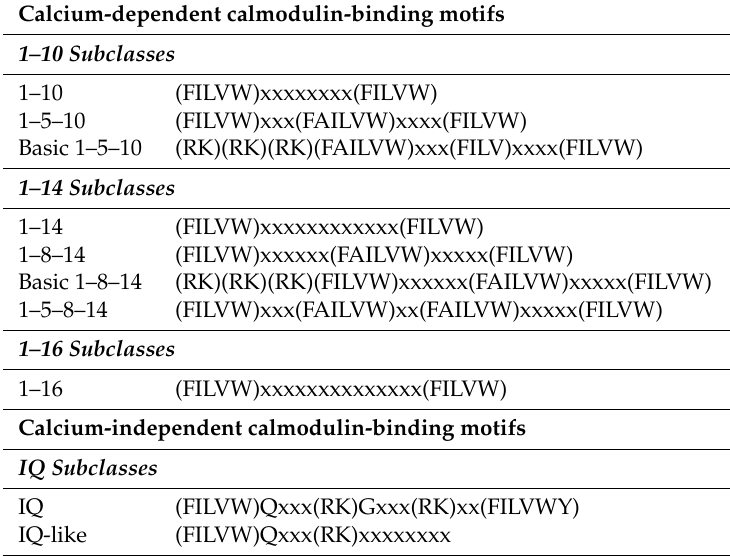
Table 1. Canonical calmodulin-binding motifs.